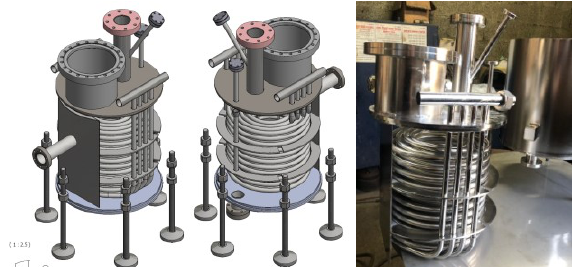
Fig. 4. on the left, a model of the revised full power version of the lithium heat exchanger, and at the right side a picture of the internal part before final welding